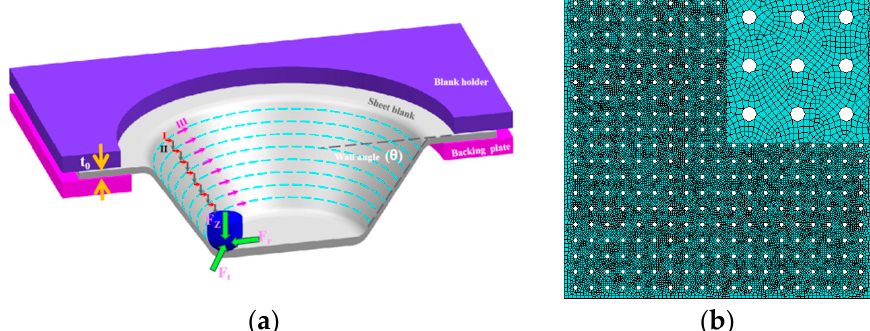
Figure 3. Schematic diagram of the incremental forming process of perforated titanium sheet. ( a ) Finite element modal. ( b ) Grid partition of the perforated titanium sheet. Table 2. Perforated titanium sheet incremental forming process parameters.